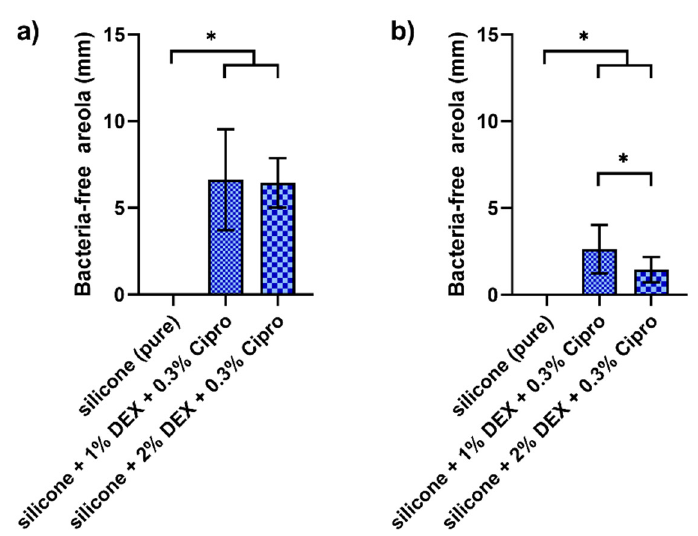
Figure 5. Diameters of bacteria-free areola of differently loaded silicone samples against Staphylococcus aureus ( a ) and Pseudomonas aeruginosa ( b ). Differences are indicated above the bars. For both bacterial strains statistically significant increases in bacteria-free areolas could be detected for both DEX and cipro loaded samples. For S. aureus , no difference in effectivity could be observed between 1% and 2% DEX, whereas for P. aeruginosa the bacteria-free areola was greater for 1% DEX. Data are given as box plots and significances are labeled with * p < 0.05.